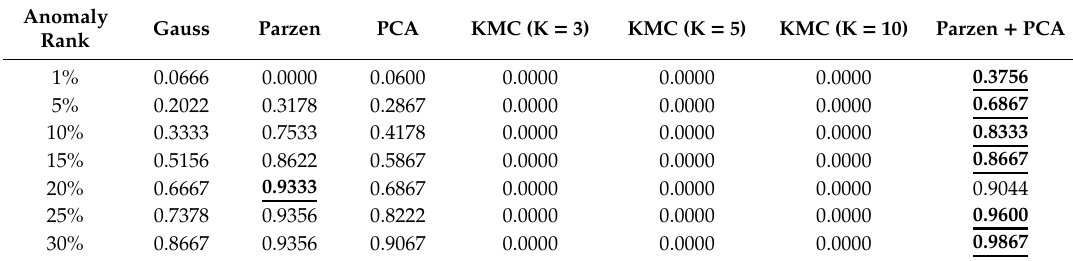
Table 14. True detection rate of each anomaly detection algorithm based on the e-mail contents dataset (IT Admin). Best performance is shown in bold and underlined (number of normal behaviors in the test set: 17,077, number of malicious behaviors in the test set: 15).